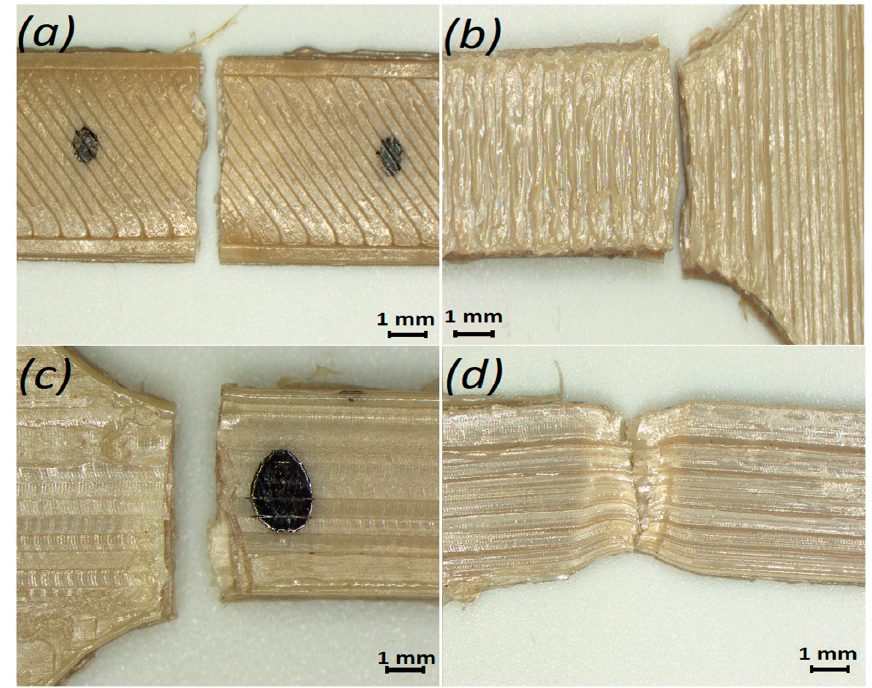
Figure 9. Fractured samples with different infill angles α : ( a ) 45°; ( b ) 90°; ( c ) 180° with heat treat- ment; and ( d ) 180° without heat treatment. and ( d ) 180 ◦ without heat